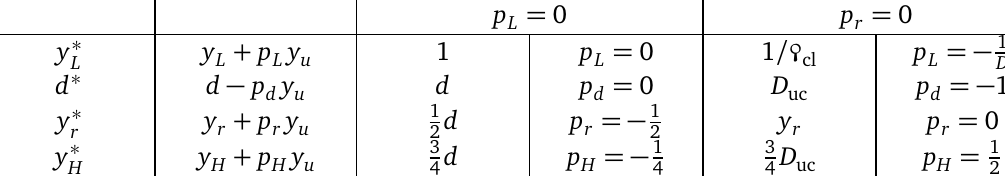
corresponds to leaving the scaling L leaves the scaling r = p L